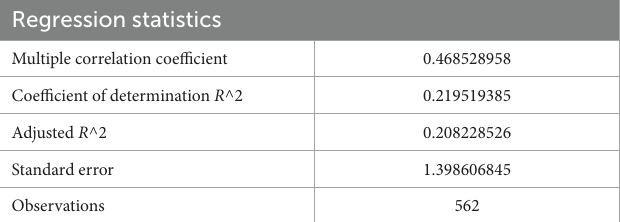
TABLE 6 Regression values associated with permanence factors.